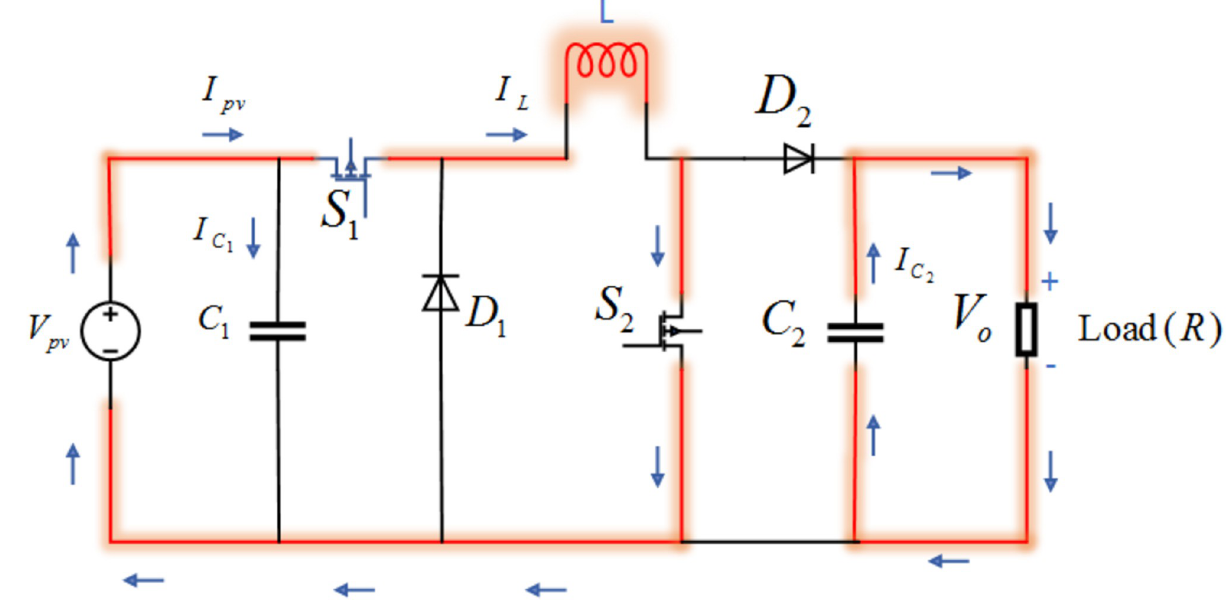
Fig 5. Switch ON mode of the non-inverted buck-boost